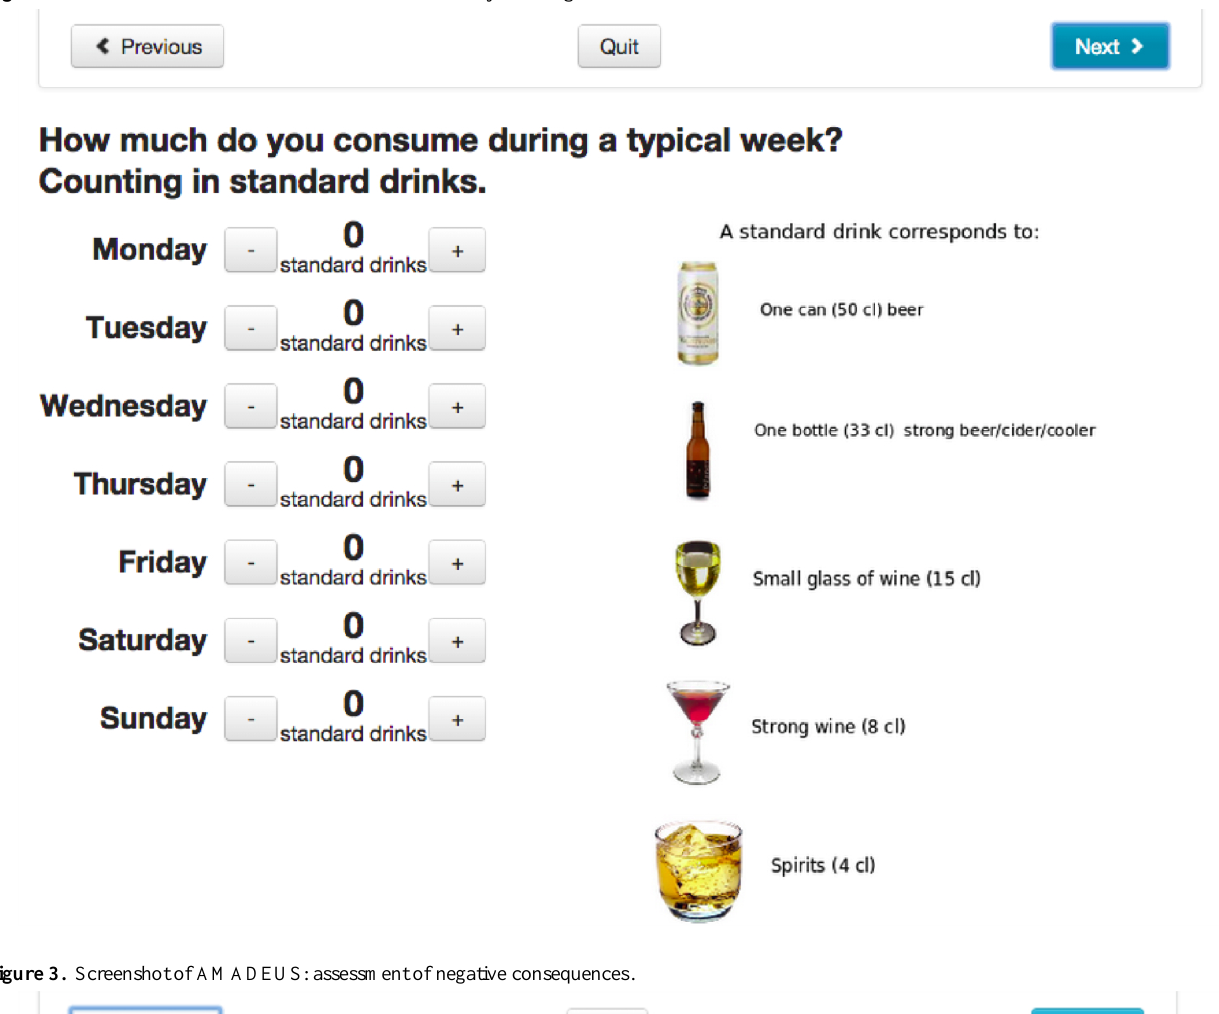
Figure 2. Screenshot of AMADEUS: assessment of weekly drinking.